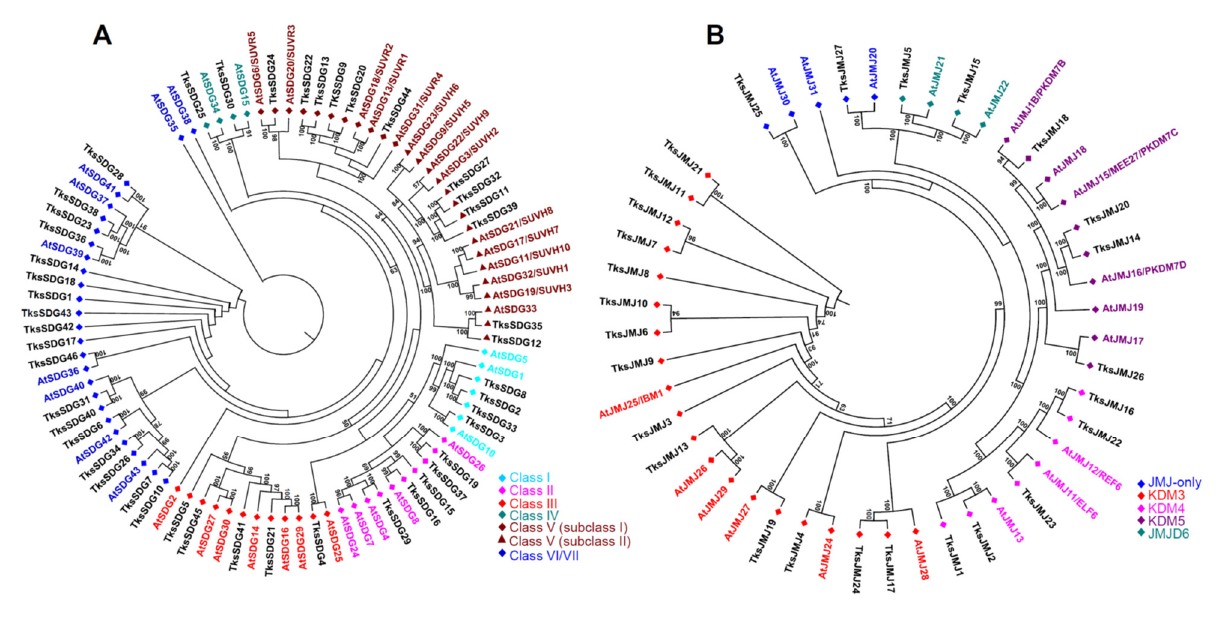
Figure 1. Phylogenetic tree of SDG ( A ) and JMJ ( B ) proteins of Taraxacum kok-saghyz and Arabidopsis thaliana (in colour according to their respective classes). The numbers near the tree branches represent bootstrap values.